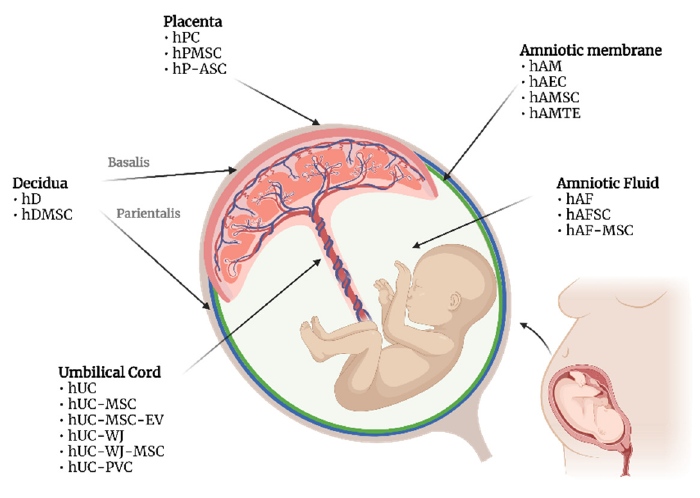
Figure 1. PnD used in oncological animal models. Nomenclatures follow the Consensus for Tissue and Cell Nomenclature recently published by the COST SPRINT Action (CA17116) consortium: MSC—mesenchymal stromal/stem cells; hPC—human placenta cells; hPMSC—human